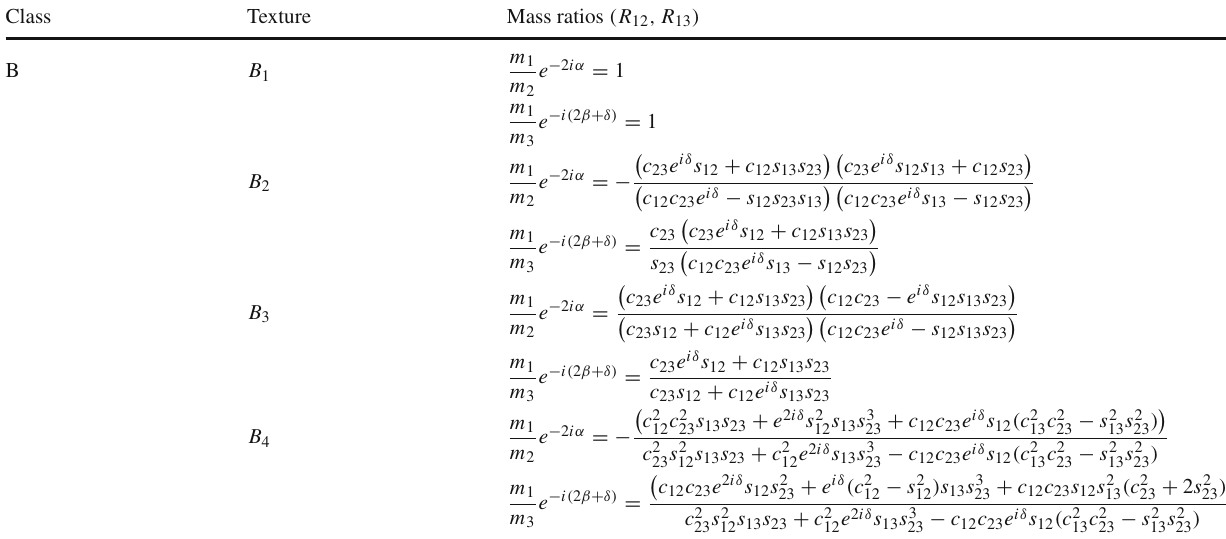
Table 3 Mass ratios for class B